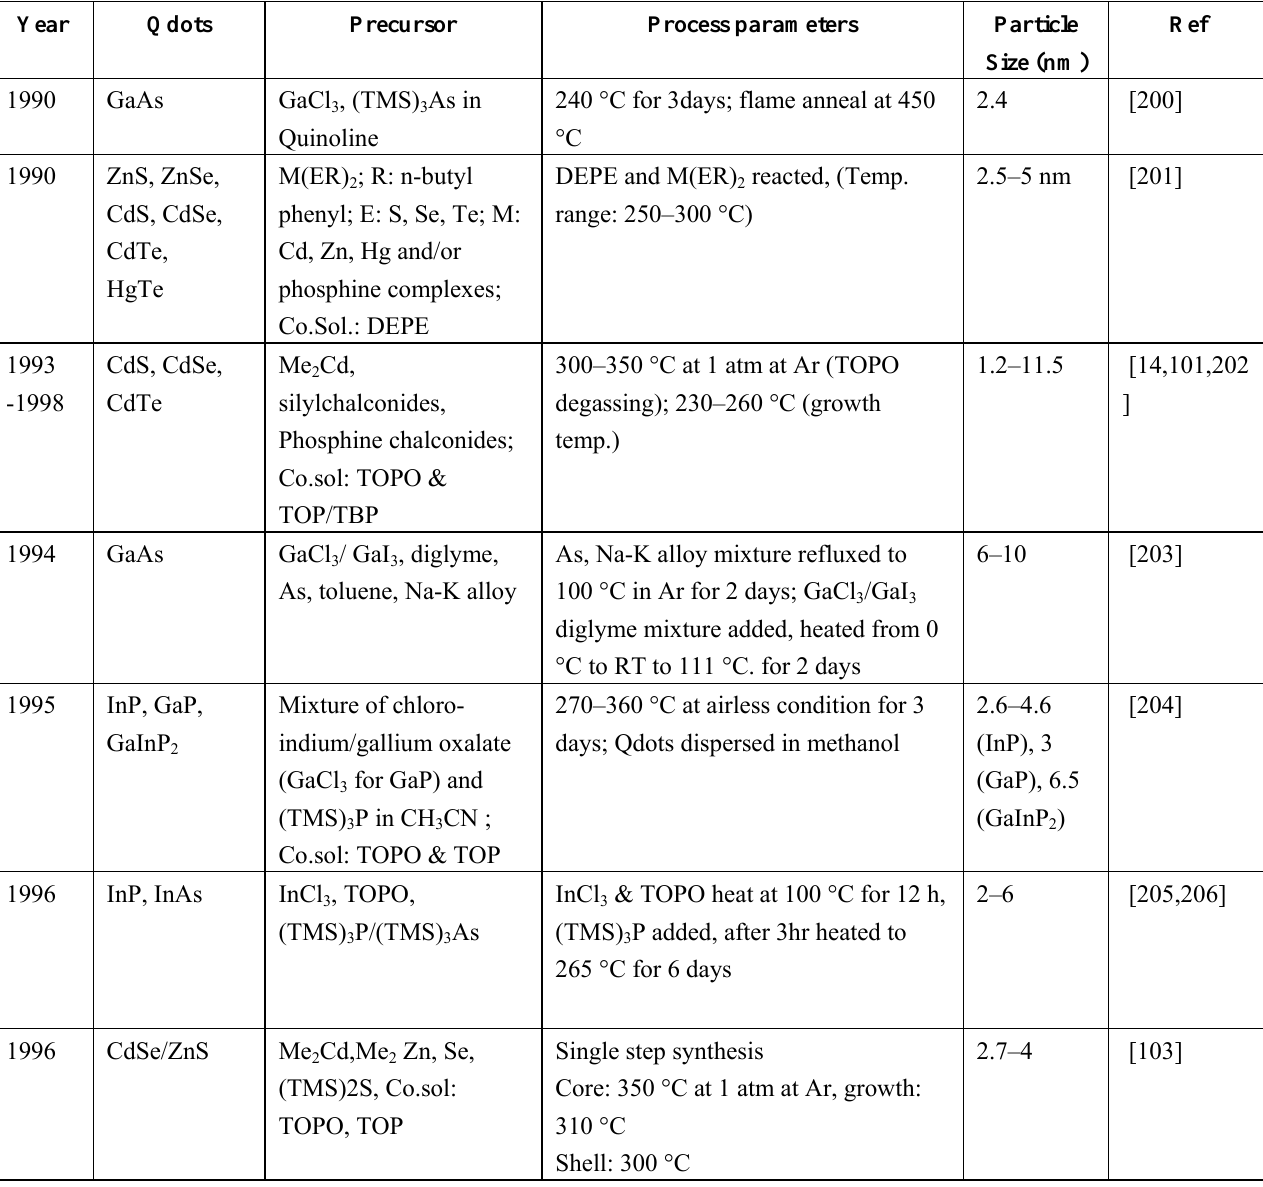
Table 3. Synthesis of different sized Qdots using hot-solution decomposition